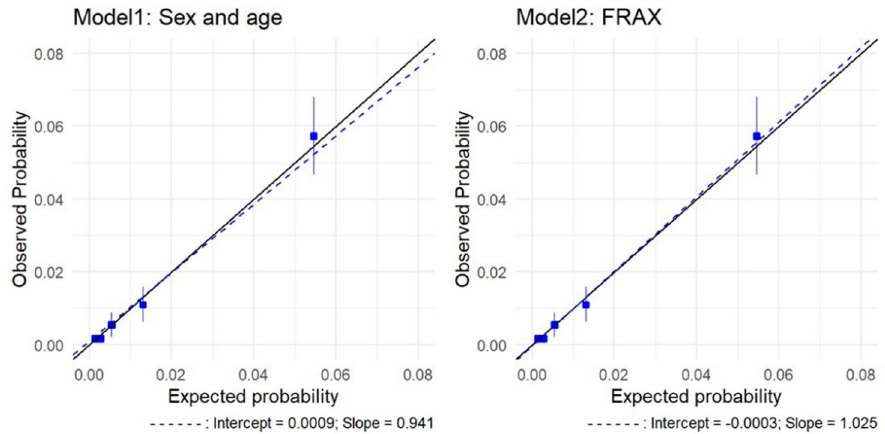
Figure 1. Calibration plots of hip fracture predictions for FRAX and the age and sex model in the comparative analysis: observed risk and average predicted probabilities by probability fifths. Solid line: reference. Blue boxes: quintiles.